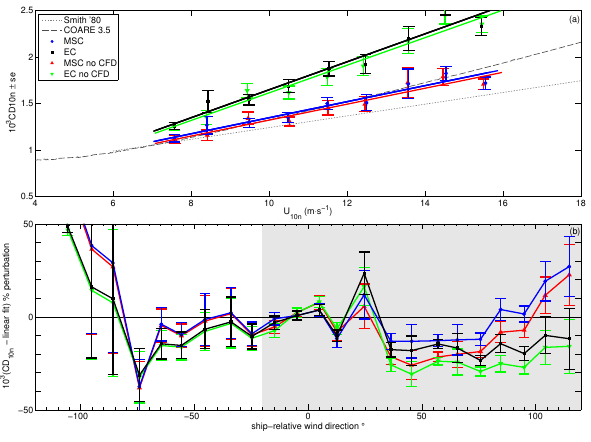
Figure 6. (a) Measurements either without correction for wave- scale bias (EC) or with correction applied to the vertical velocity only (MSC) for wind speeds 7ms − 1 < U 10n < 16ms − 1 ( n = 335) and relative wind directions between − 20 and + 50 ◦ (where a wind on the bow is at 0 ◦ ). Lines are linear fits to the measurements. (b) variation of the difference between measured drag coefficients and the linear fits against relative wind direction for the same wind speed criteria ( n = 663). Both panels also show measurements (with and without MSC) which have not had CFD-derived corrections to mean wind speed and height applied. Note that CFD corrections were only applied for the shaded